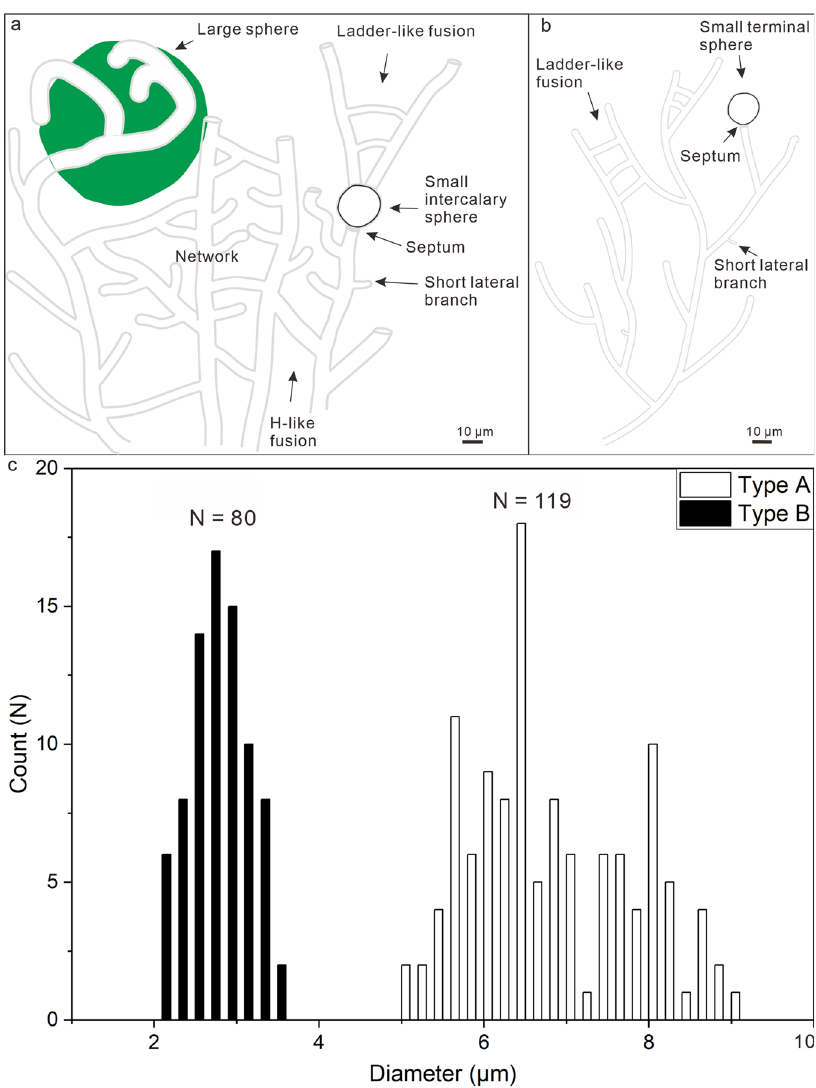
Fig. 5 Morphological reconstruction and frequency distribution of fi lament diameter. a , b Sketches of Type A ( a ) and Type B ( b ) fi laments and associated spheres. c Frequency distribution of fi lament diameter of microfossils from Datang. N = 119 fi laments for Type A fi lament and N = 80 fi laments for Type B fi